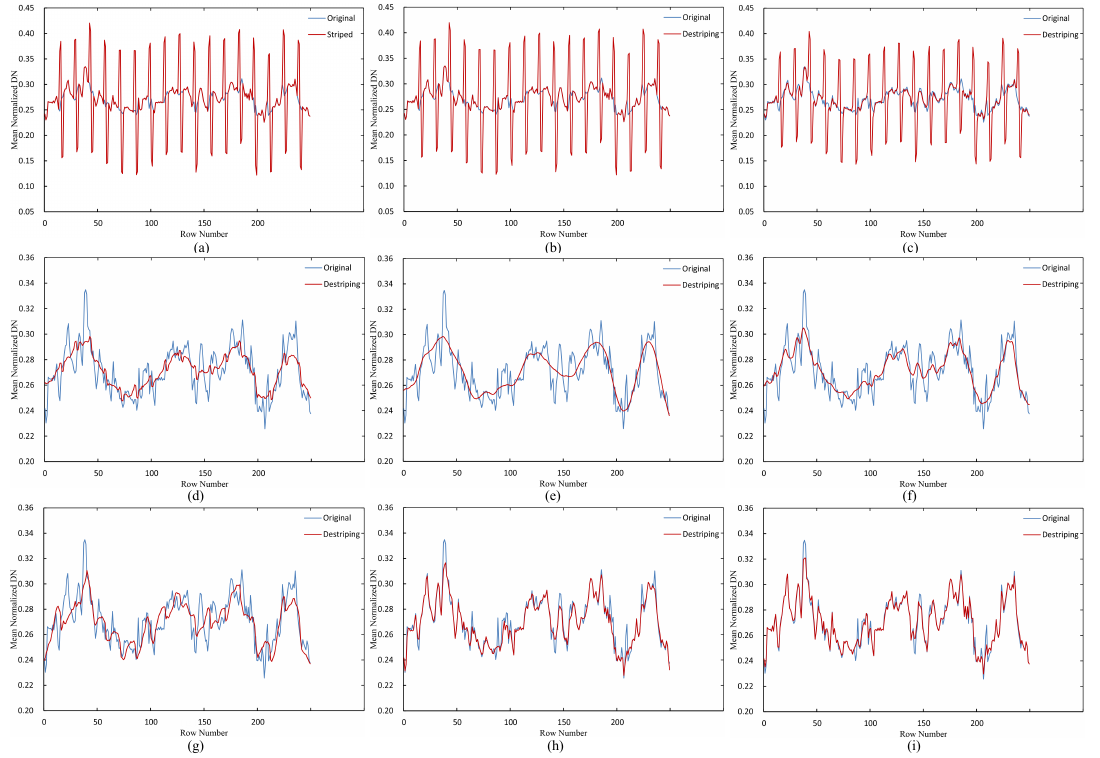
Figure 16. Mean cross-track profiles of comparison methods for simulated stripe Washington DC Mall hyperspectral data S4. ( a ) striped data; ( b ) BM3D; ( c ) SNRCNN; ( d ) GF-based; ( e ) WAFT; ( f ) UV; ( g ) HUTV; ( h ) SUV; ( i )